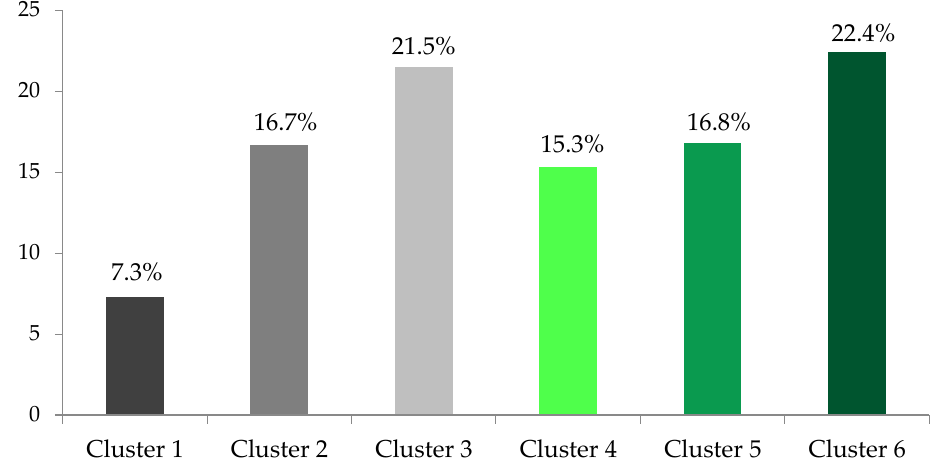
Figure 1. Grouping of Hungarian settlements on the basis of land use indicators (%). The proportion of the six clusters within the settlement population is between 7.3% and 22.4%, i.e., the difference between the largest and the smallest subcluster is roughly three times, which can be considered as a statistically well-balanced grouping.